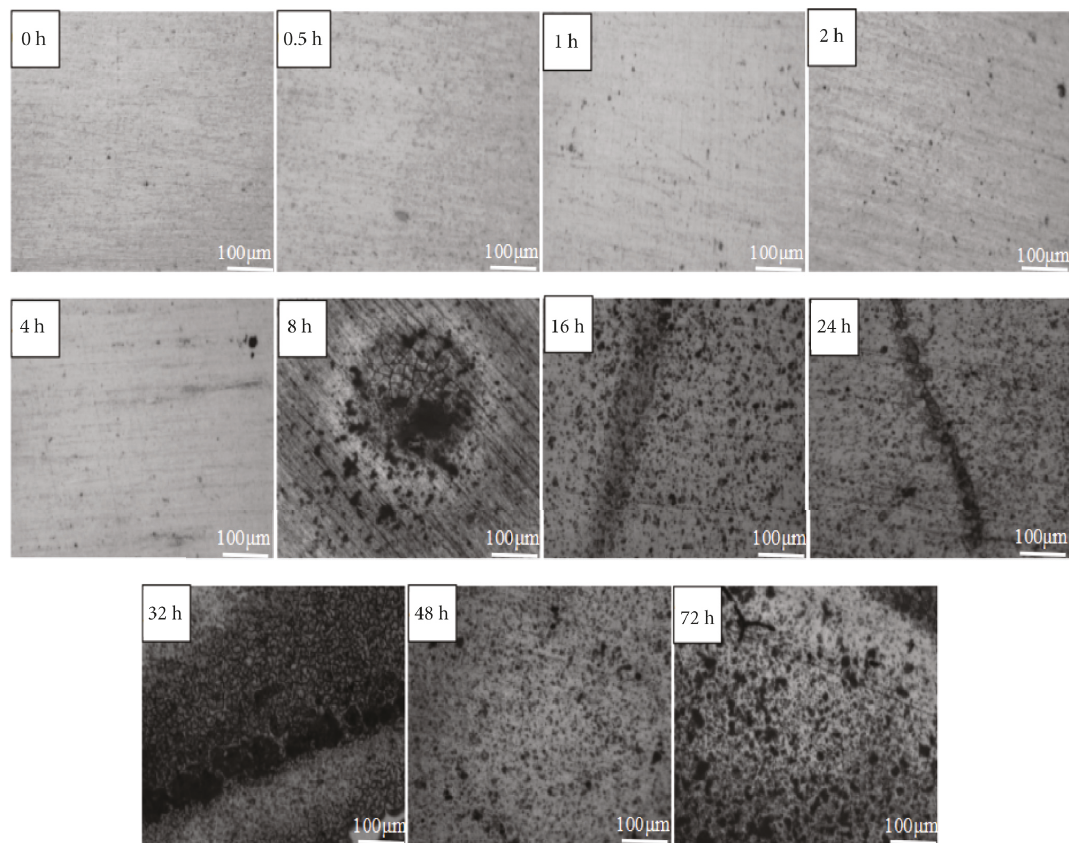
Figure 4: Superficial morphology of Al–Li alloy at different salt spray time.